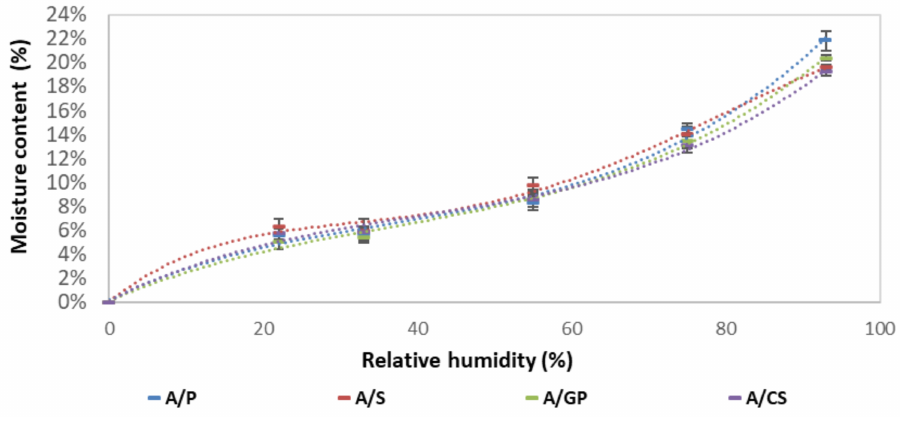
Figure 4. Sorption isotherms of the four